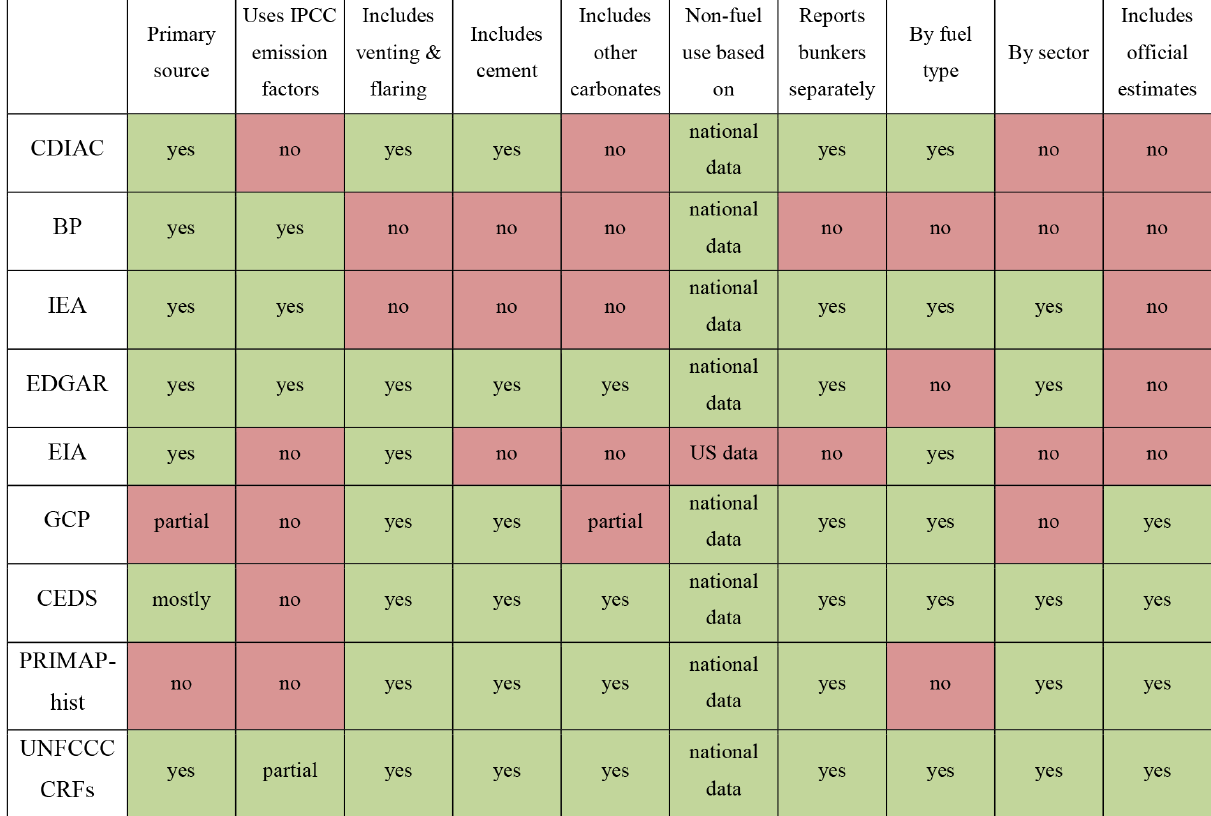
Table 3. System boundaries and other key features of global FFI-CO 2 emissions datasets as published. Comparison of some important general characteristics of nine emissions datasets, with bold font indicating a characteristic that might be considered a strength. Columns four to six refer to CO 2 emissions estimates for industrial processes and product use. Since all datasets are under development, these